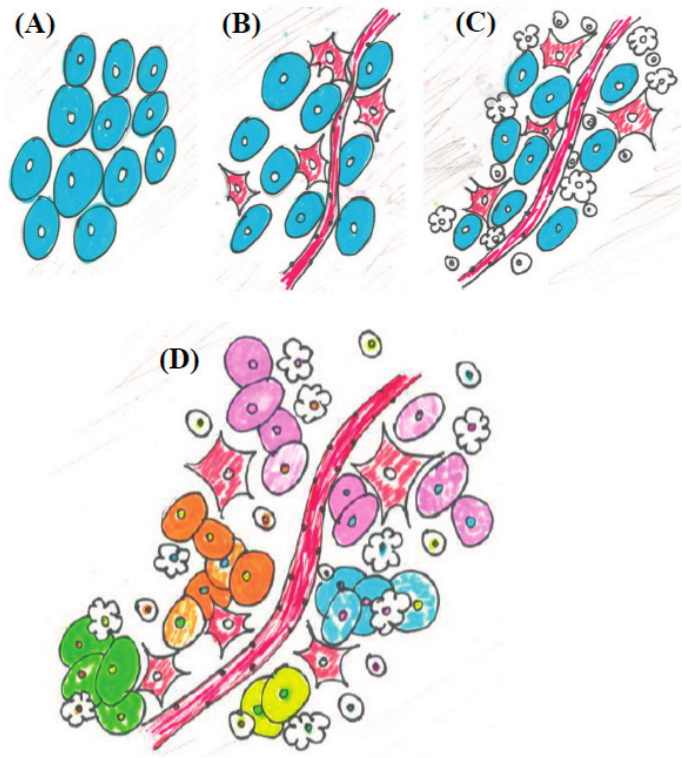
Figure 1. An illustration of the conceptual progression of the tumor microenvironment from a reductionist view to cancer as a dynamic system. ( A ) A highly reductionist view. Tumors viewed as a homogenous population malignant clones; ( B ) Cancer cells integrated into the circulatory system, as represented by including blood vessels and fibroblasts, as seen in Hanahan and Weinberg 2000; ( C ) The tumor microenvironment becomes more complex. In addition to blood vessels and fibroblasts, immune cell types of various kinds are introduced into the system, as seen in Hanahan and Weinberg 2011; ( D ) The emerging view of a malignancy as a heterogeneous and dynamic system. Not only are blood vessels, fibroblasts, and immune cells in the tumor microenvironment, but there are distinct clonal populations of cancer cells intermingled with a variety of different immune cells and other cell